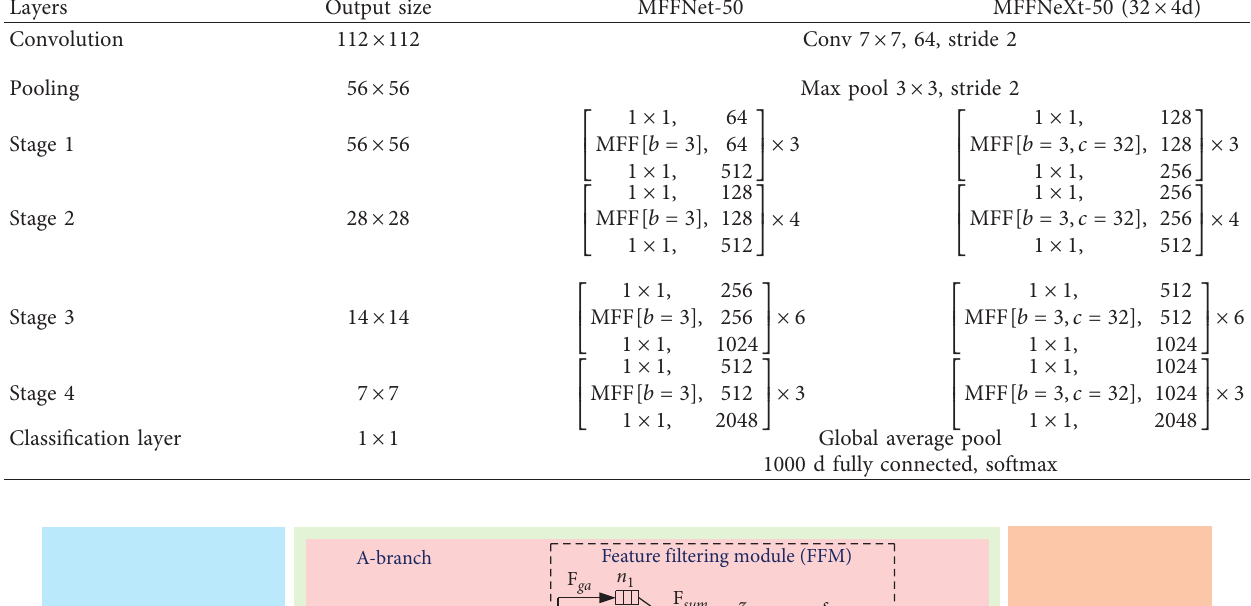
Table 1: The third and fourth columns show the architecture of MFFNet-50 and MFFNeXt-50, respectively. Layers